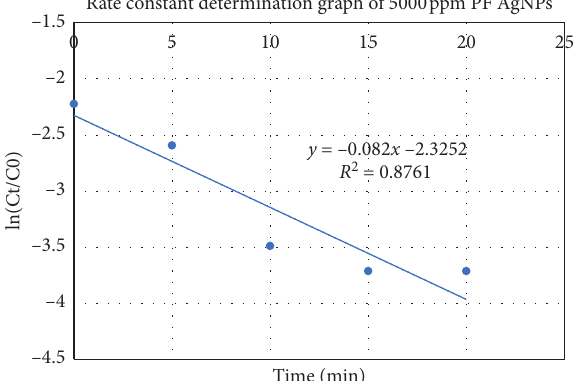
Figure 29: Rate constant graph of 5000ppm PF AgNPs.